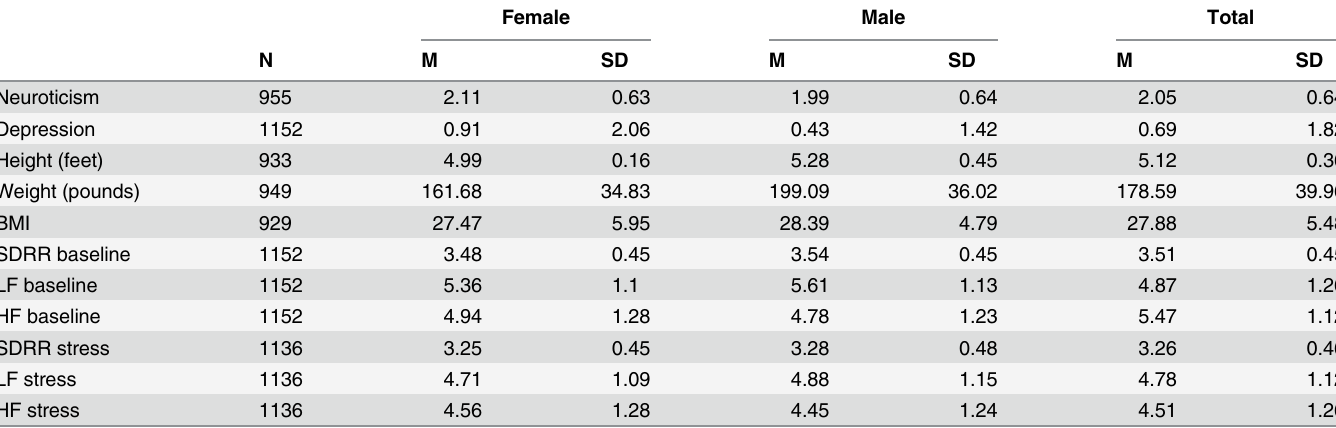
Table 1. Ns, Means and Standard Deviations for Experimental variables and